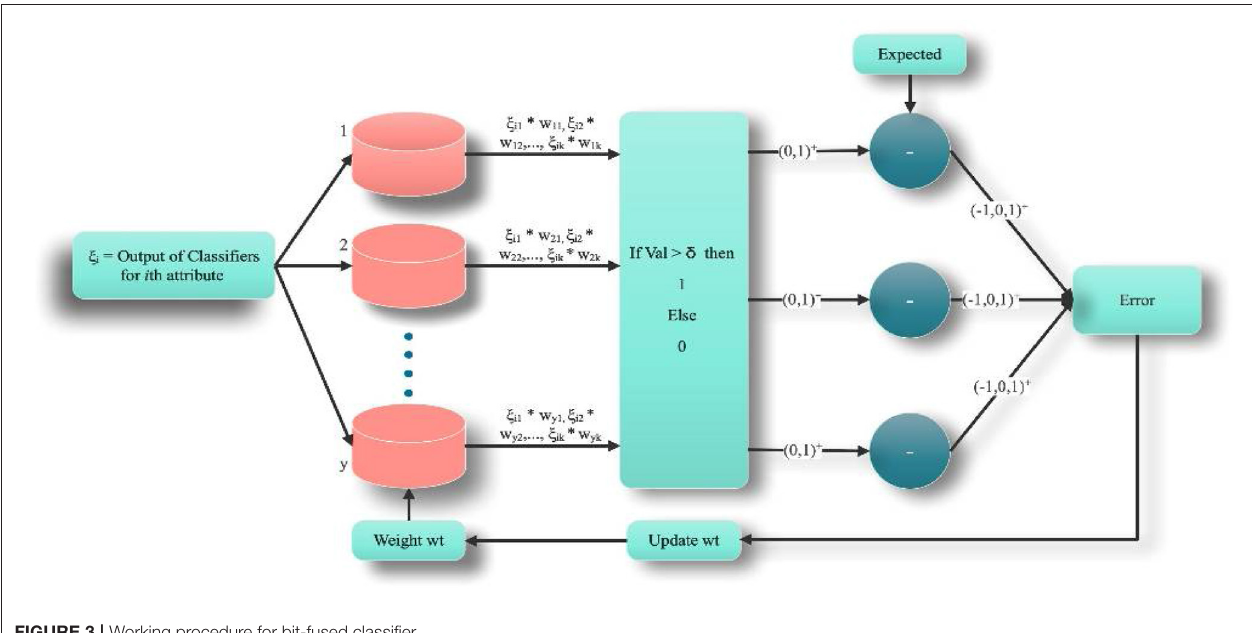
FIGURE 3 | Working procedure for bit-fused classifier.